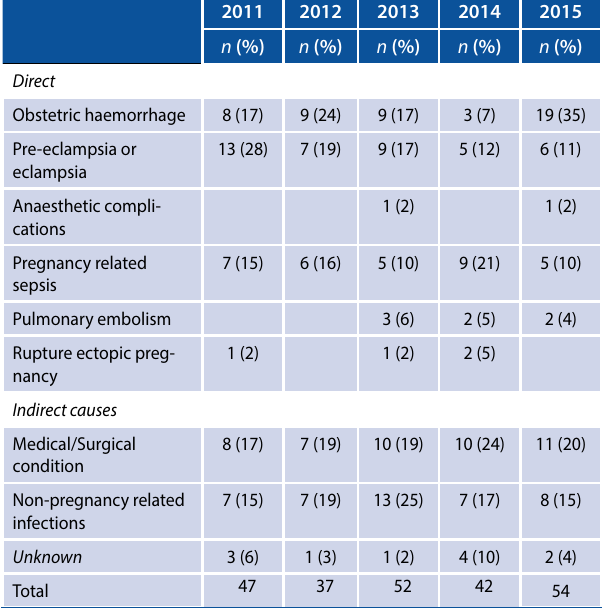
Table 2: Causes of maternal death at Pietersburg Hospital ( n = 232)